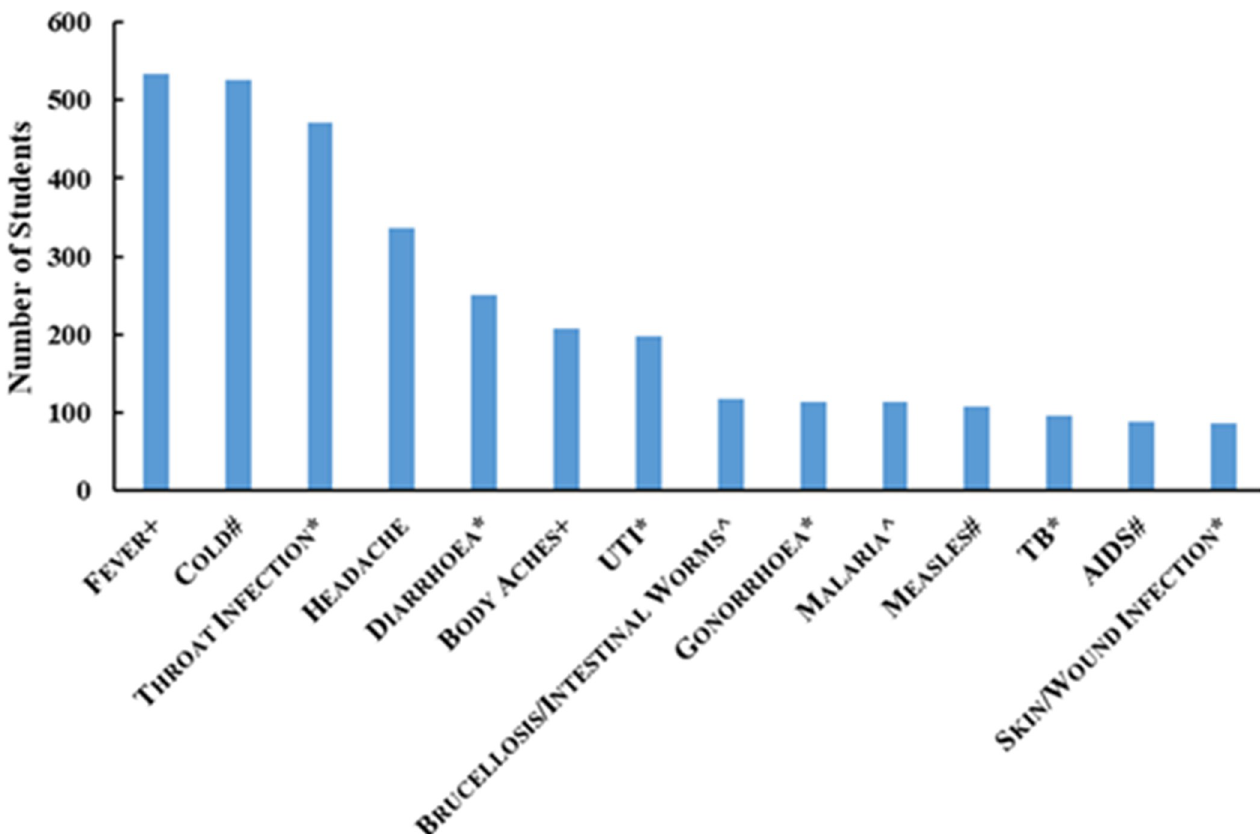
Fig 1. Participants’ identification of conditions they thought were treatable with antibiotics ( + could be either viral or bacterial; # viral; � bacterial; ^